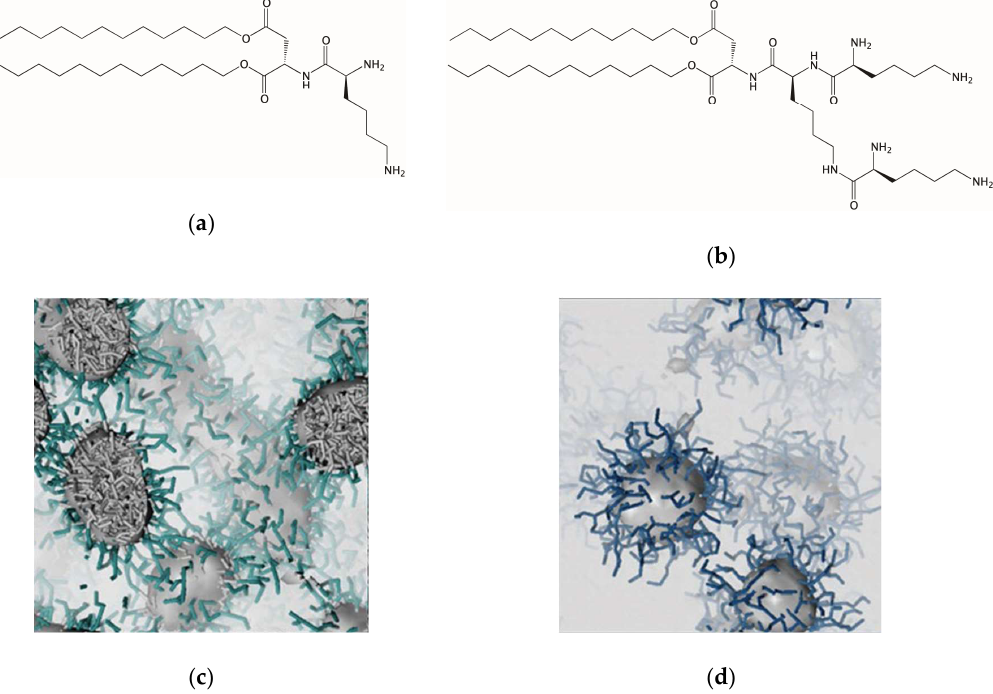
Figure 6. Chemical structure of the amphiphilic dendrons L-G 1 ( a ) and L-G 2 ( b ). Generation of worm- like ( c ) and spherical nanomicelles ( d ) upon self-assembly of L-G 1 and L-G 2 under 150 mM NaCl and pH = 7.4 conditions, as obtained from multiscale molecular simulations. In panels ( c ) and ( d ) the common hydrophobic micellar core is evidenced as a gray-shaded surface (and gray sticks), while the hydrophilic shell is shown as forest green and steel blue sticks for L-G 1 ( c ) and L-G 2 ( d ), respectively. In both cases, the solvated salted environment is portrayed as a light gray field. Adapted from [26] with the permission of The Royal Society of Chemistry.